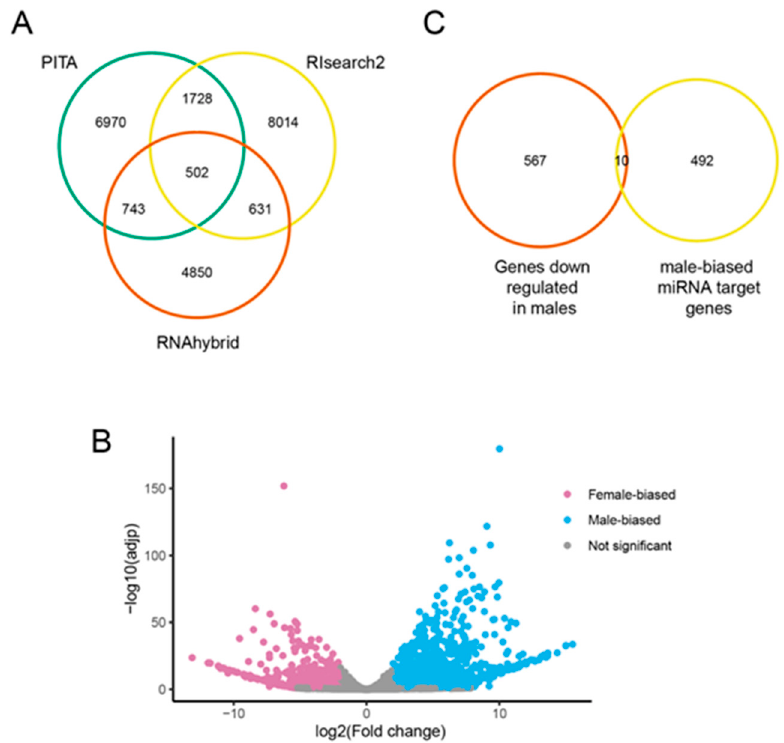
Figure 4. Male-biased miRNA targets. ( A ) Each circle shows the number of possible target genes from each of the three target prediction programs (PITA, Rlsearch2, and RNAhybrid). ( B ) Results of the RNA-seq analysis. The x -axis represents the log2 fold change of each expressed gene in the aphid genome. The y -axis shows the statistical significance of differential gene expression ( − log10 adjpval) for each gene. Genes that were differentially expressed at a false discovery rate (FDR) of less than 0.05 and change by greater than 4 fold are shown with pink for female-biased genes and blue for male-biased genes. ( C ) Venn diagram comparing the miRNA predicted target with genes down-regulated in males.